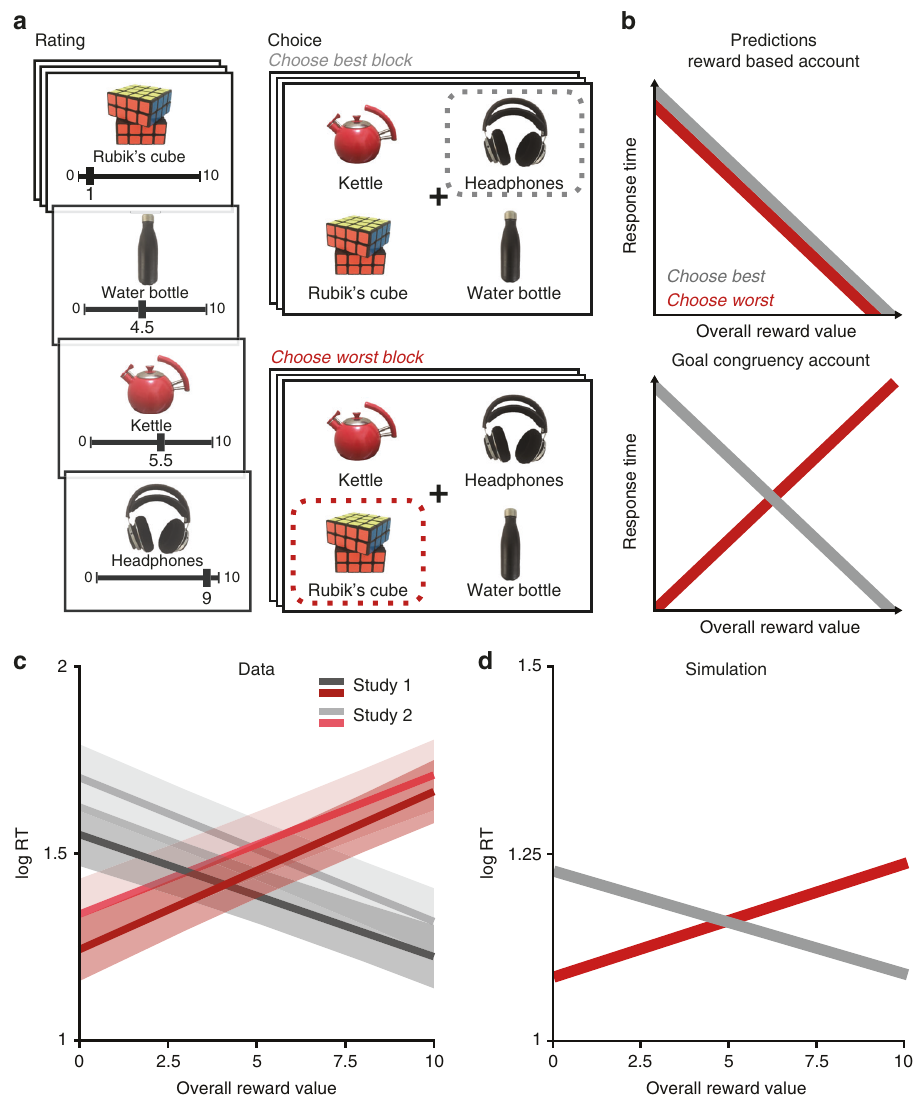
Fig. 1 Overall value effects on RT are driven by goal congruency rather than reward value. a After evaluating each item in isolation (left), participants saw sets of four options and (in separate blocks) were instructed to choose either the best or the worst option (right). The same example is shown for both blocks but each choice sets was only viewed once in a session. b Top: A reward-based account predicts that RTs should decrease with overall value of the set, irrespective of the choice goal. Bottom: A goal congruency account predicts that RTs should decrease with overall value in Choose-Best blocks but instead increase with overall value in Choose-Worst Blocks. c Both Study 1 (behavioral) and Study 2 (fMRI) fi nd the task-speci fi c RT reversal predicted by a goal congruency account (see also Supplementary Study 1, Supplementary Discussion). Shaded error bars show 95% con fi dence intervals. d Our empirical fi ndings were captured by an LCA model that took goal values (rather than reward values) as